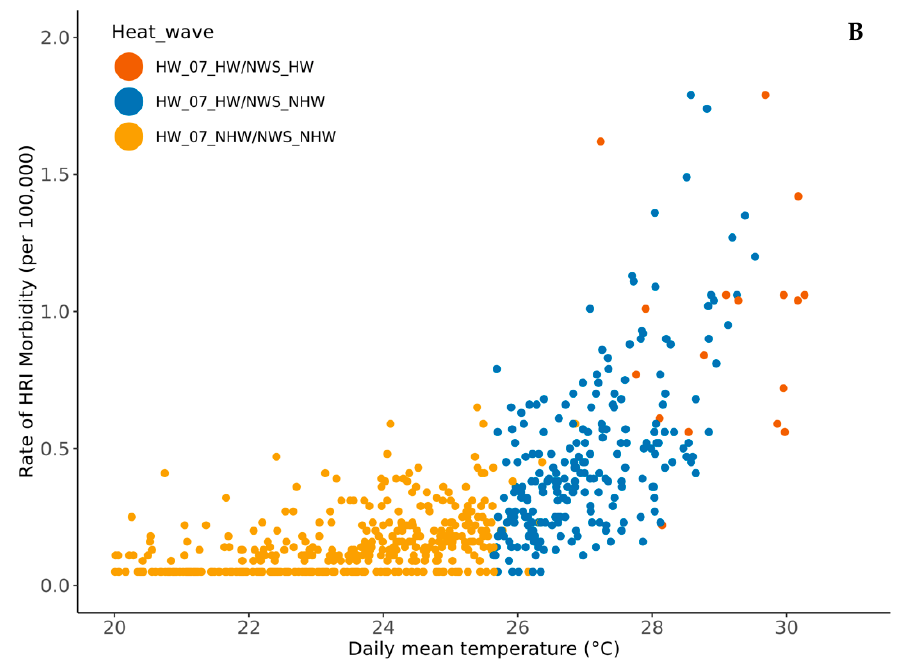
Figure 3. Comparison of the effective heat wave definition with the NWS-Heat alerts. The X -axis represents daily temperature in degrees Celsius (Coastal: maximum temperature and Piedmont: minimum temperature). The Y -axis represents the daily rate of heat-related illness morbidity per 100,000 population members. Each dot represents an observation corresponding to daily temperature and the rate of HRI morbidity during the study period. Panel ( A ) represents the Coastal region and panel ( B ) represents the Piedmont region. The dots in the scatter plot are color-coded with three possible combinations: (1) Red: Categorized as heat wave day from our results (HW_15 or HW_07) and the NWS; (2) Blue: Categorized as heat wave day only based on our result; (3) Beige: Not flagged as a heat wave day from our results nor the NWS.